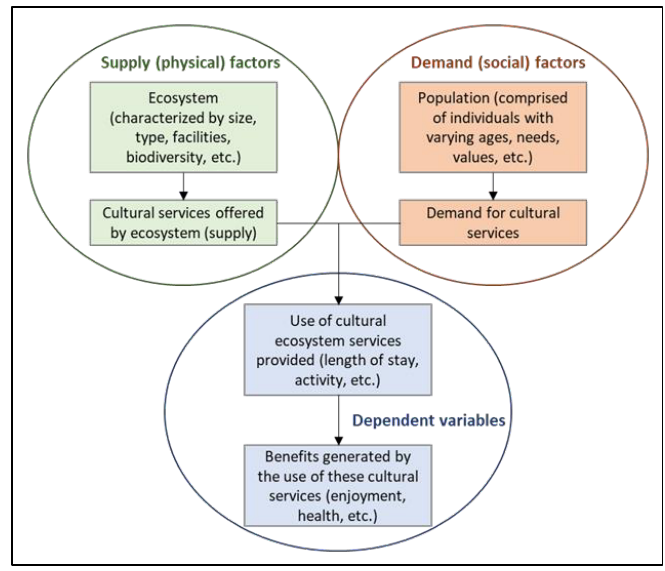
Figure 2. Confluence model: how supply and demand factors determine the use of cultural ecosystem services [17] (p. 49, adapted).